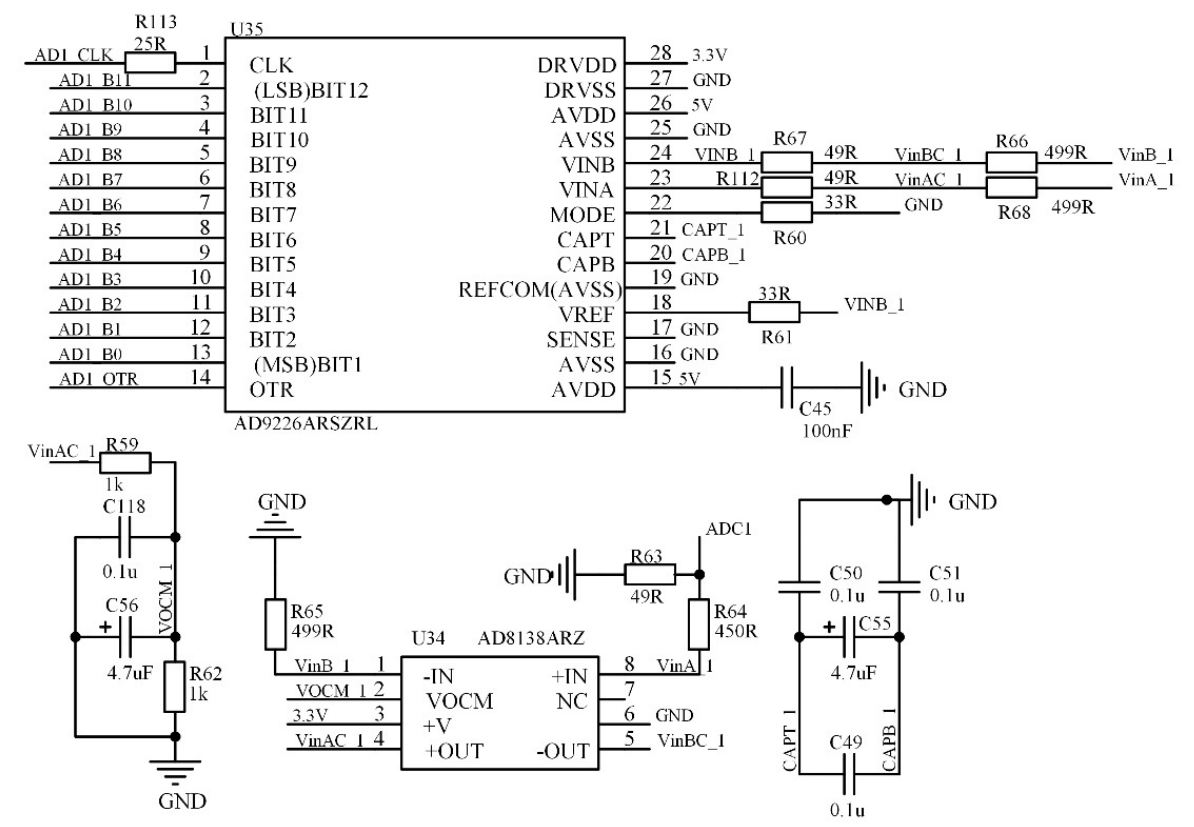
Figure 14. Design of high-precision ADC circuit.